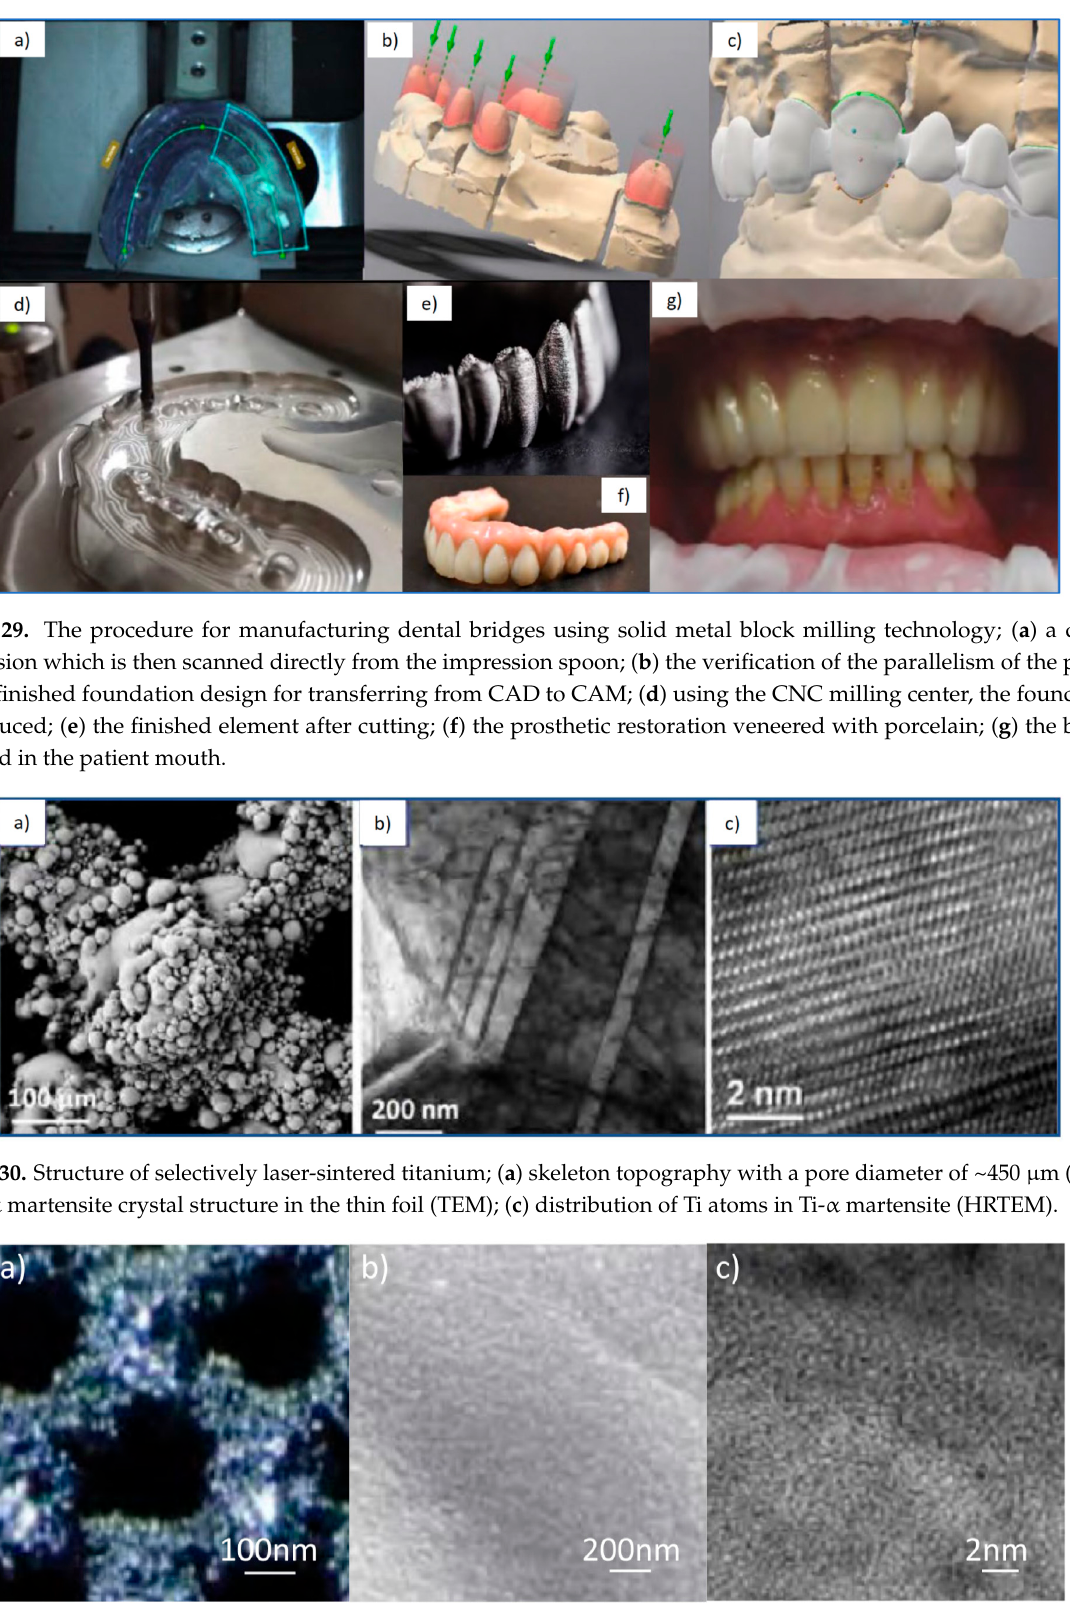
2 sinter produced by the CAD/CAM